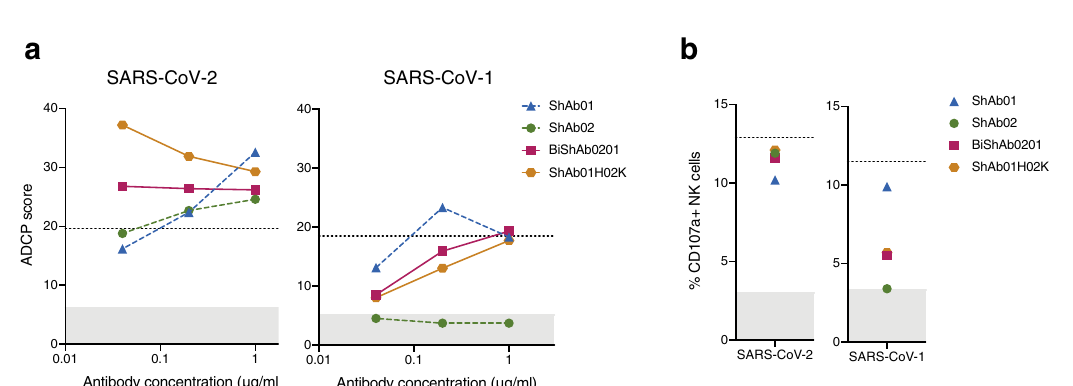
Fig. 6 | Structure-based design of multi-domain ShAb molecules. a Left, SARS- CoV-2 RBD is shown in surface representation with ShAb01 and ShAb02 VNARs in ribbon representation. The distance from the ShAb02 VNAR C-terminus to either theN-orC-terminusofShAb01isshown.Right,designschematicsofmulti-speci fi c molecules BiShAb0201, and ShAb01H02K ‘ knob-in-hole ’ constructs, and trivalent ShAb-Foldonconstructs. b BLImeasurementofACE2-inhibitiontoSARS-CoV-2WA- 1RBD(center)andS-2P(right).Themeasurementsareperformedwithimmobilized SARS-CoV-1 RBD, with ShAb molecules and ACE2 in solution. c Neutralization of